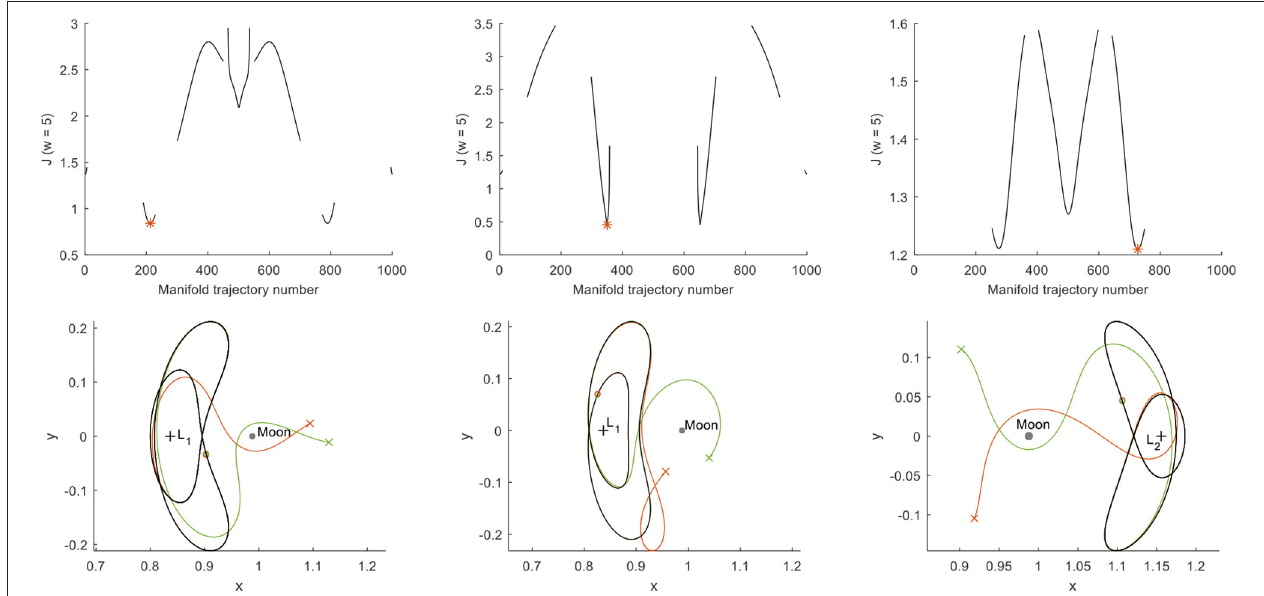
FIGURE 6 | Search for homoclinic connections for a fixed propagation time of one synodic period (FLTR: transfers 1–3).